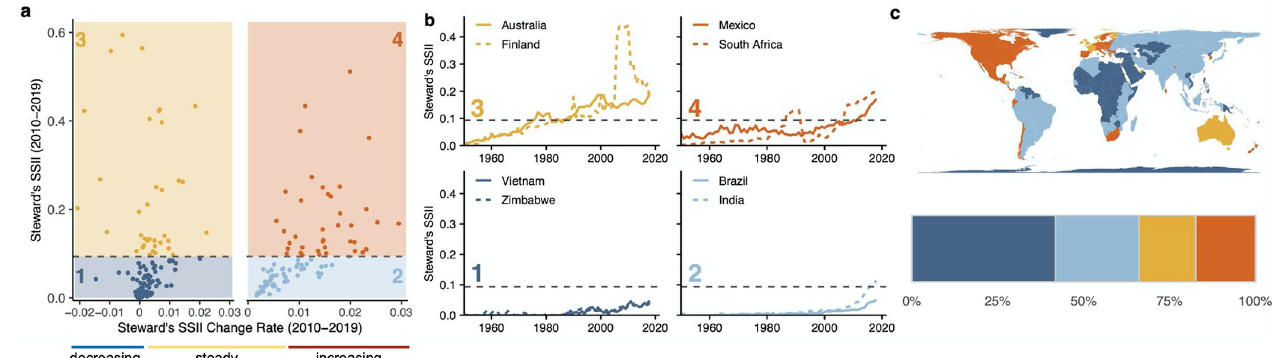
Fig 5. Typologies of nations’ data coverage and trends. (a) Mean values and change rates in Steward’s SSII over the previous decade (2010–2019). Horizontal dashed line represents the global mean of Steward’s SSII. Left panels show nations with no significant or decreasing trends in coverage. Right panels show nations with significant ( p < 0.01) increasing trends in coverage. We categorized nations into the following 4 main types based on Steward’s SSII status and trends over the previous decade: (1) coverage less than the global mean with no or decreasing trend (2010–2019) (42% of nations); (2) coverage less than the global mean with an increasing trend (24%); (3) coverage greater than the global mean with no or decreasing trend (17%); and (4) coverage greater than the global mean with an increasing trend (17%). ( b) Example time series for nations within each type. ( c) National assignment to quadrants. Bar plot shows percentages of nations within each quadrant. National boundaries from gadm . org . The data underlying this figure may be found in https://mol.org/indicators/ coverage and https : //github . com/MapofLife/biodiversity-data-gaps . SSII, Species Status Information Index.